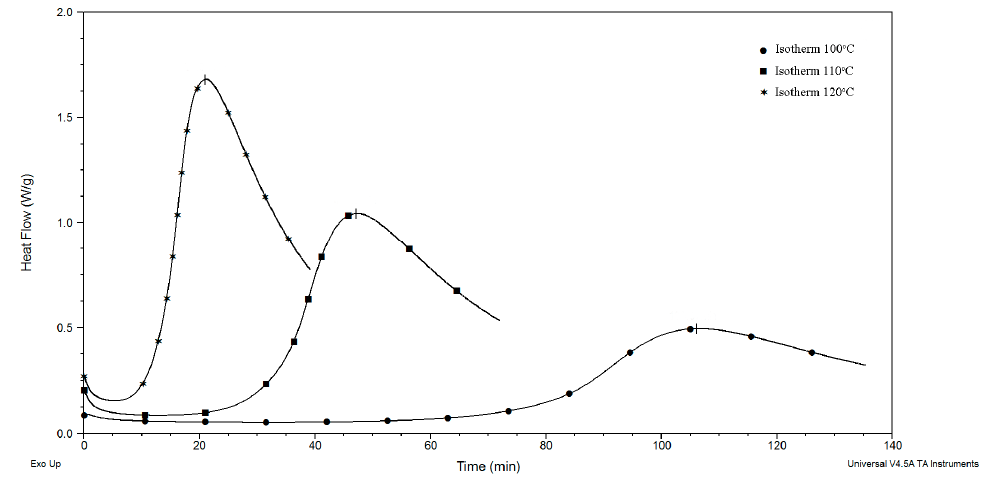
Figure 3. DSC curves of oxidation induction time of silverskin fat samples.